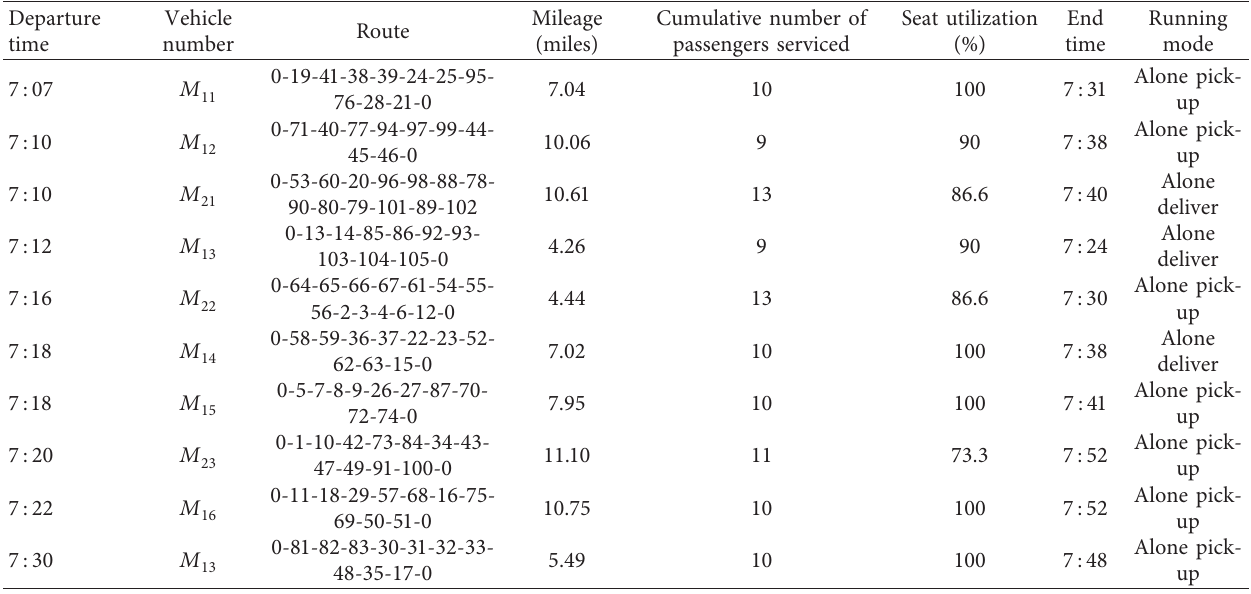
Table 11: Optimization results under pick-up and deliver alone in the optimal service area.